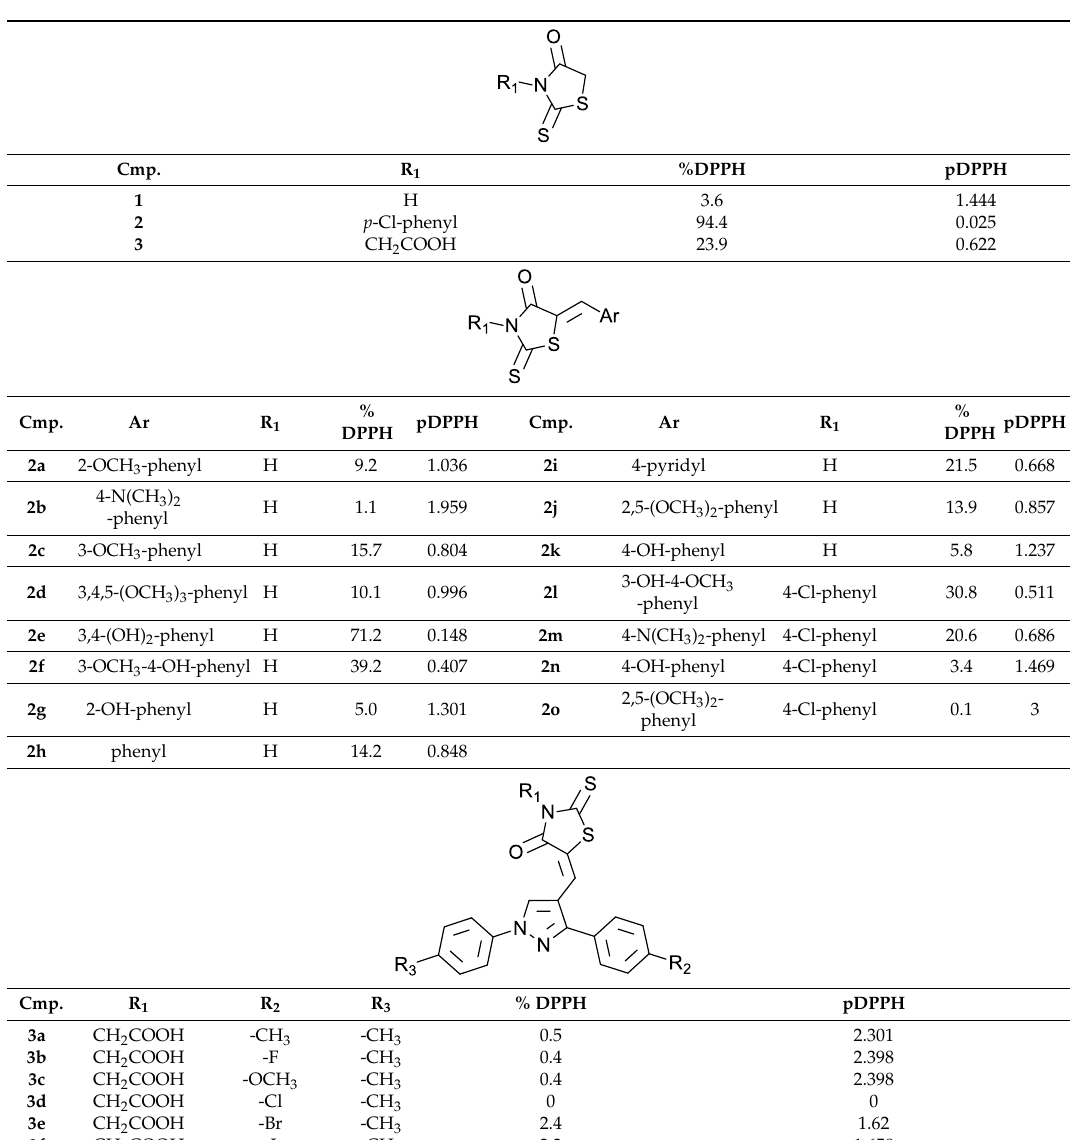
Table 2. Structure and the observed antioxidant activity of rhodanine derivatives expressed as % 1,1-